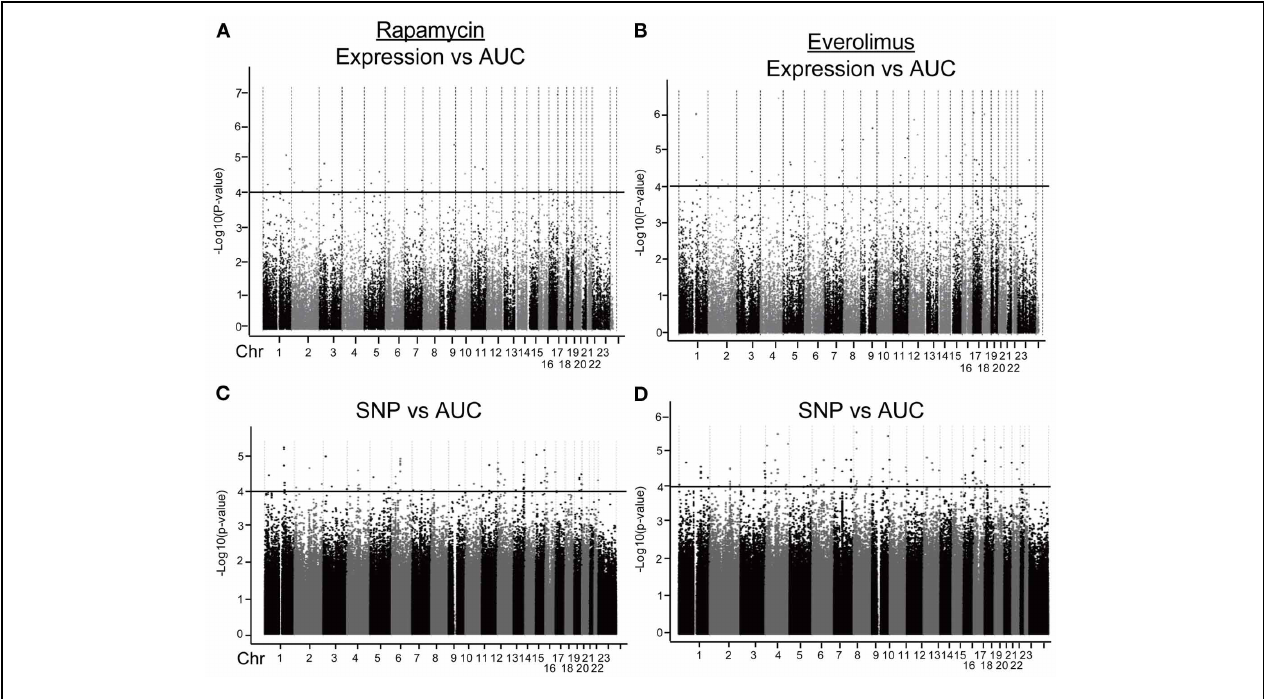
Everolimus (D) . The x-axis represents chromosomal locations of gene probe sets or SNPs, and the y-axis represents the − log 10 ( P -value) for the association of individual expression array probe sets or SNPs with AUC values. A P -value of 10 − 4 is represented by a horizontal